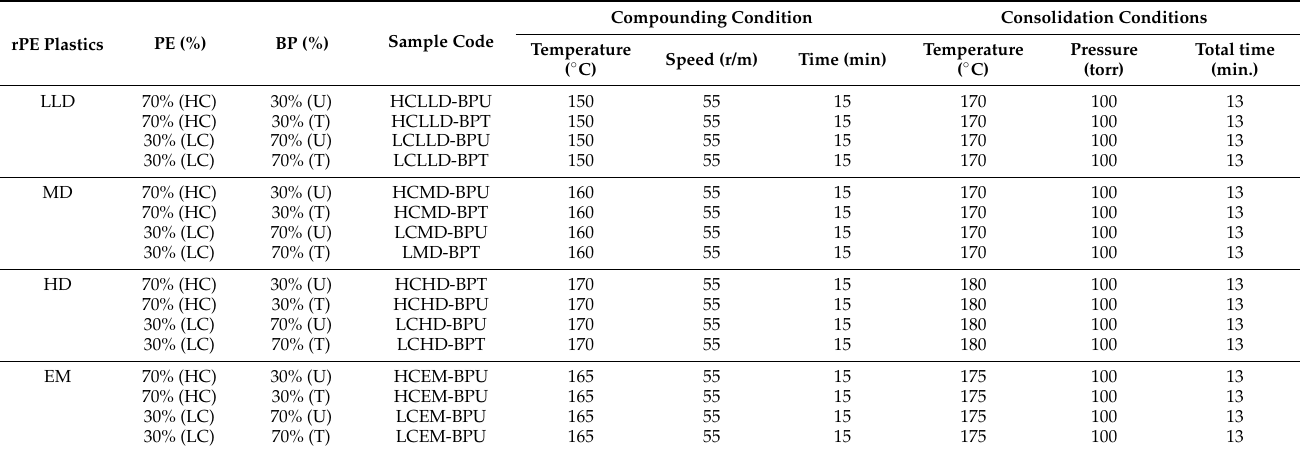
Figure 3. Compounding and consolidation process: ( a ) BP; ( b ) recycled LLDPE, MDPE, and HDPE; ( c ) compounding process; ( d ) WPC granulates; ( e ) reduced size of WPC granulates; ( f ) compression molding; ( g ) WPC board. Table 1. Experimental design of WPC